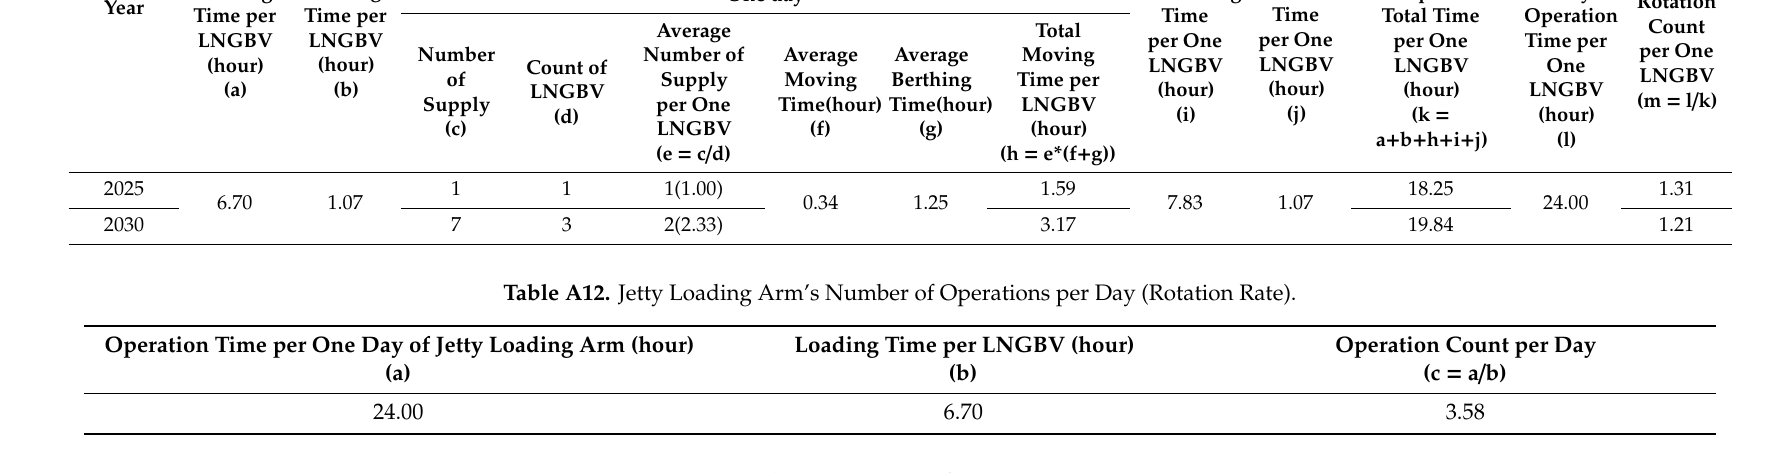
Table A13. Required LNGBVs.